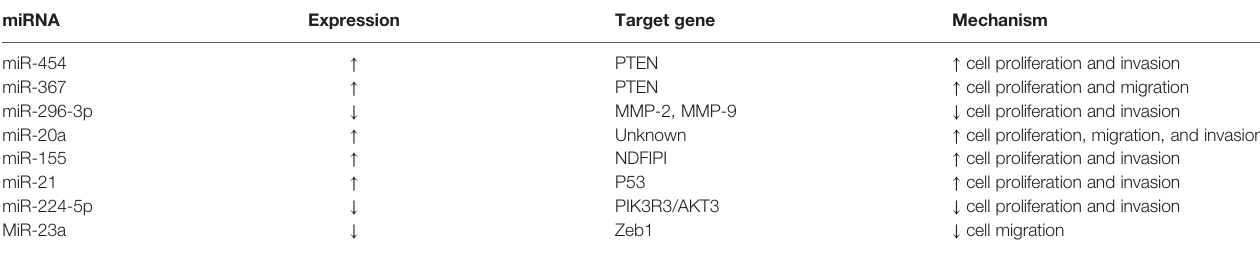
TABLE 1 | miRNAs involved in UM metastasis and their target genes. miRNA